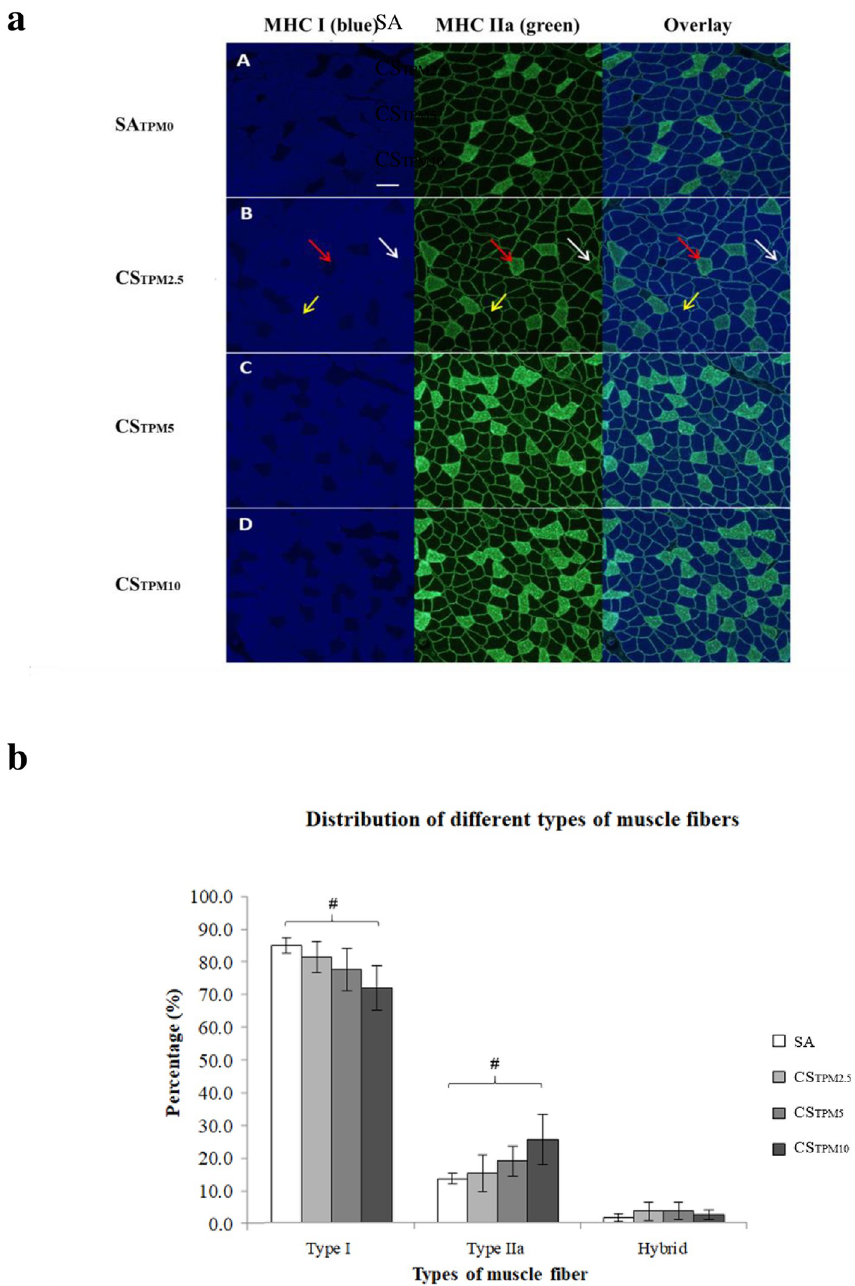
Fig 2. Muscle fiber types changes in soleus muscles upon acute cigarette smoke exposure. (a ) Cross-sections of soleus muscles from SA ( A ), CS TPM2.5 ( B ), CS TPM5 ( C ) and CS TPM10 ( D ) groups showing immunoreactivity against MHC I (blue, left panel), MHCIIa (green, middle panel) and the overlaid images (right panel). Examples of type I fibers (yellow arrows), type IIa fibers (red arrows) and type I/IIa hybrid fibers (white arrows) were indicated. Scale bar = 100 μ m. ( b ) Histogram summarizing the percentage distribution of type I, type IIa and type I/IIa hybrid fibers in soleus from SA group and CS groups. All data are presented as mean ± SEM. � indicates p < 0.05 for overall ANOVA comparison; # indicates p < 0.05 in post-hoc